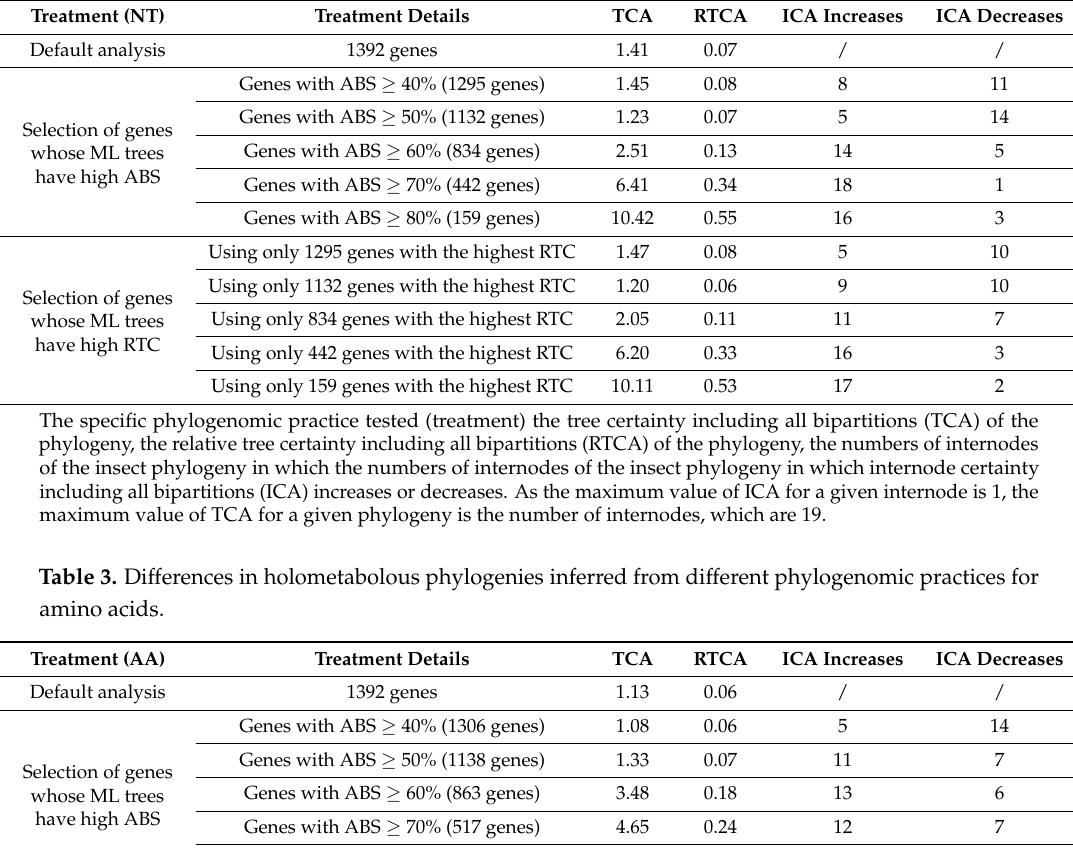
Table 2. Differences in holometabolous phylogenies inferred from different phylogenomic practices for nucleotides.